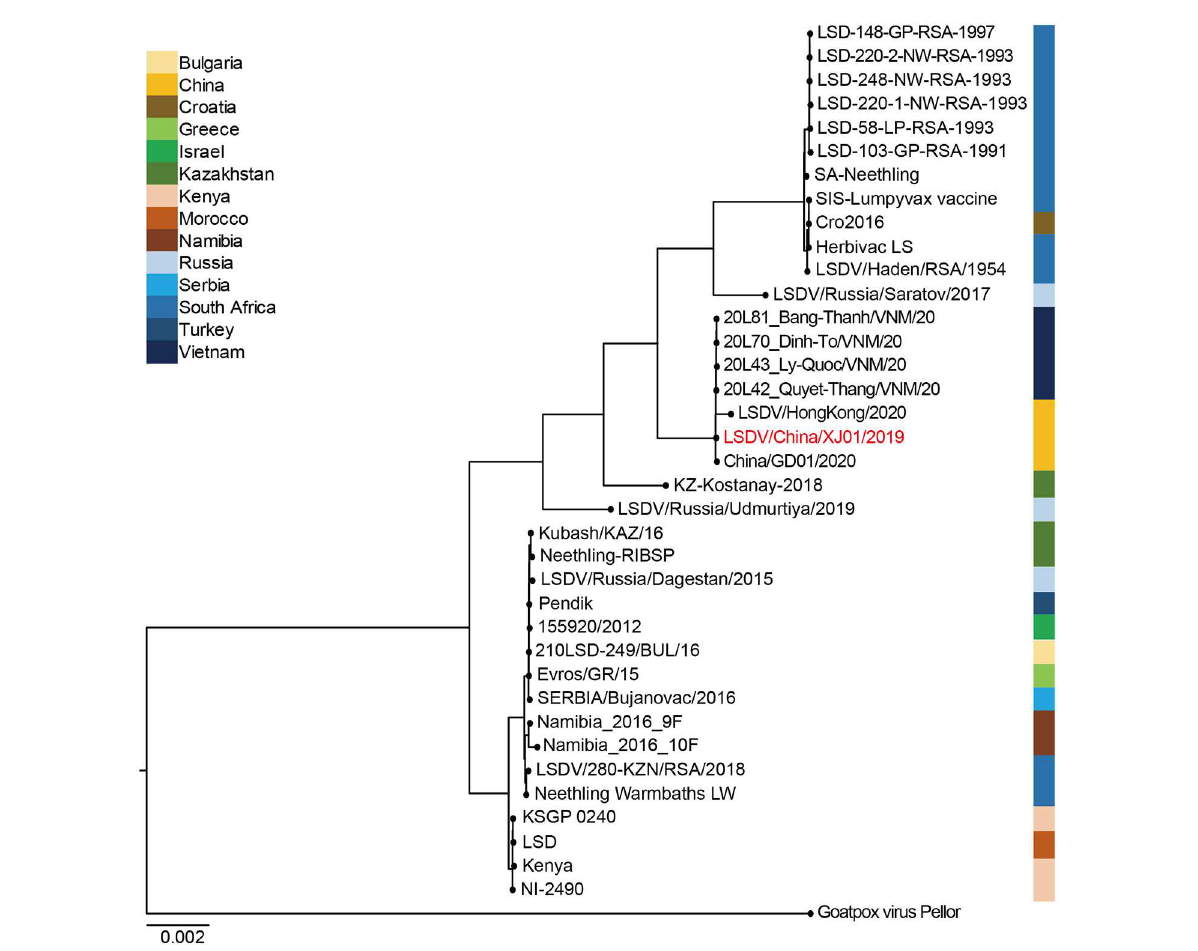
FIGURE3 Bayesian maximum clade credibility tree of whole-genome sequences of Lumpy skin disease virus. The whole-genome MCC tree was constructed using the BEAST software package (v. 2.4.3) and then visualized by FigTree (v1.4.3). The LSDV genome sequenced in this study are labeled in